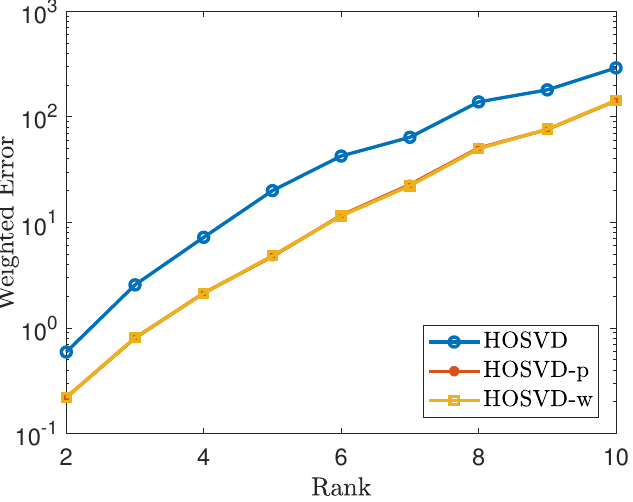
Figure 2. Tensor of size 50 × 50 × 30 × 30 using the uniform sampling pattern: plots the errors of the (cid:107)W ( 1/2 ) ( (cid:98) T −T ) (cid:107) F form . The lines labeled as HOSVD, HOSVD-p and HOSVD-w represent the results (cid:26) (cid:107)W ( 1/2 ) (cid:107) F for solving (4), (5) and (6),